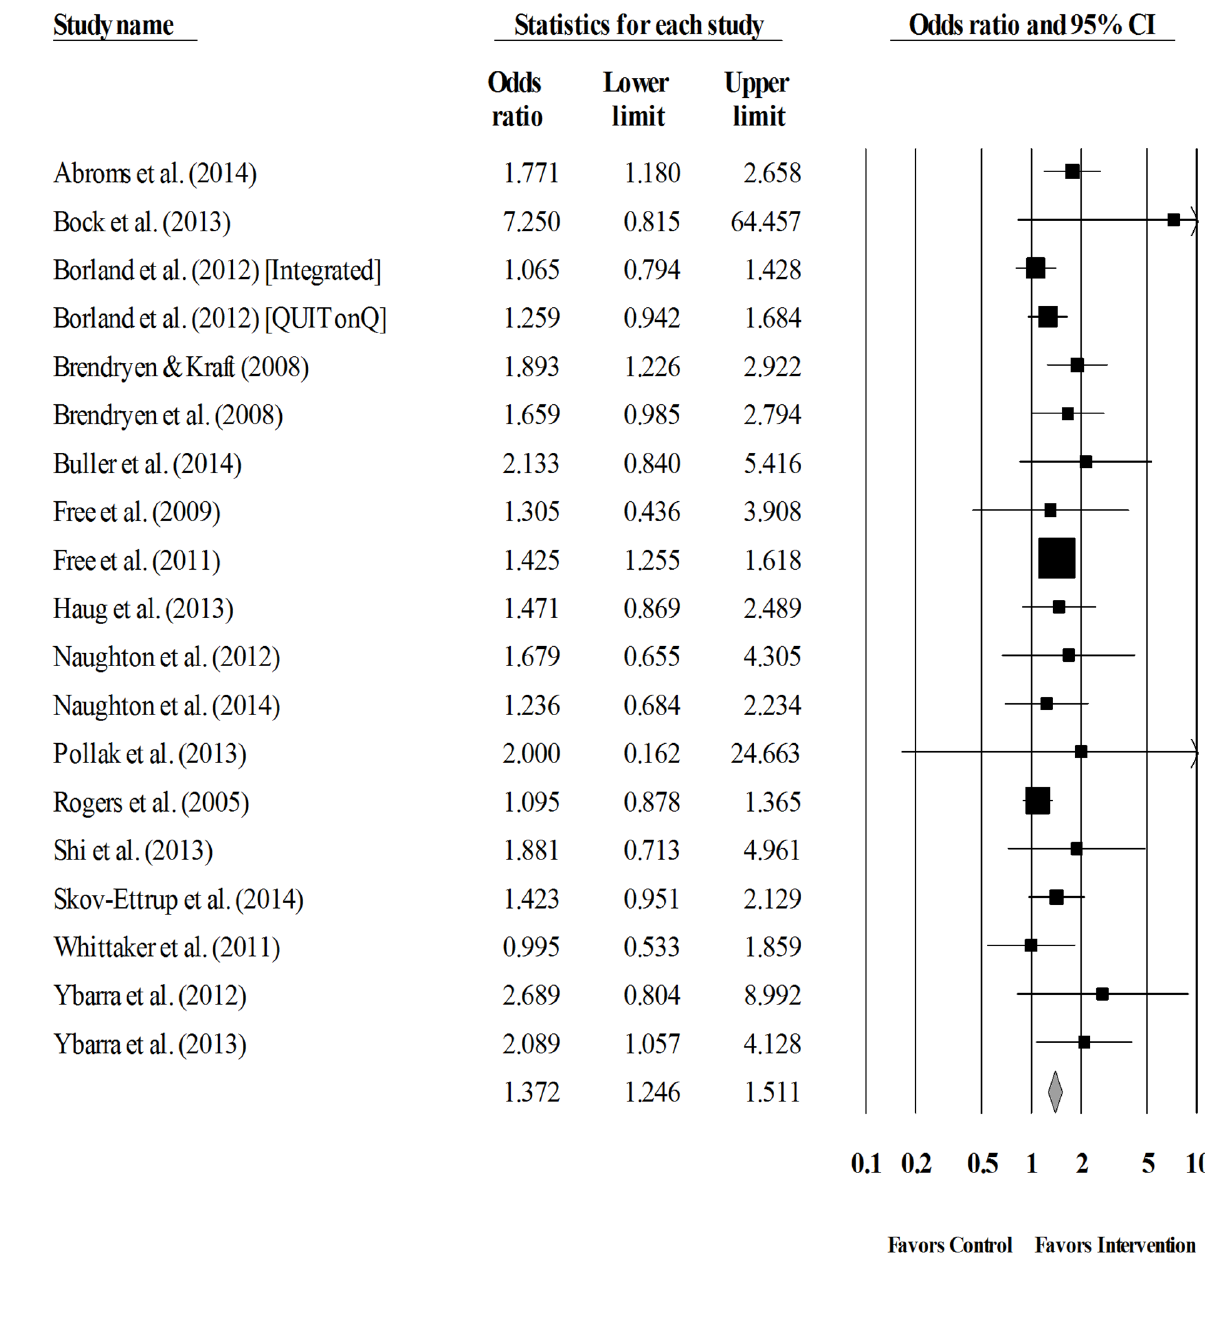
Figure 2. Forest plot of the overall odds ratio and the corresponding 95% confidence intervals for smoking abstinence. The size of the square representing the odds ratio for each study is proportional to its weight in the